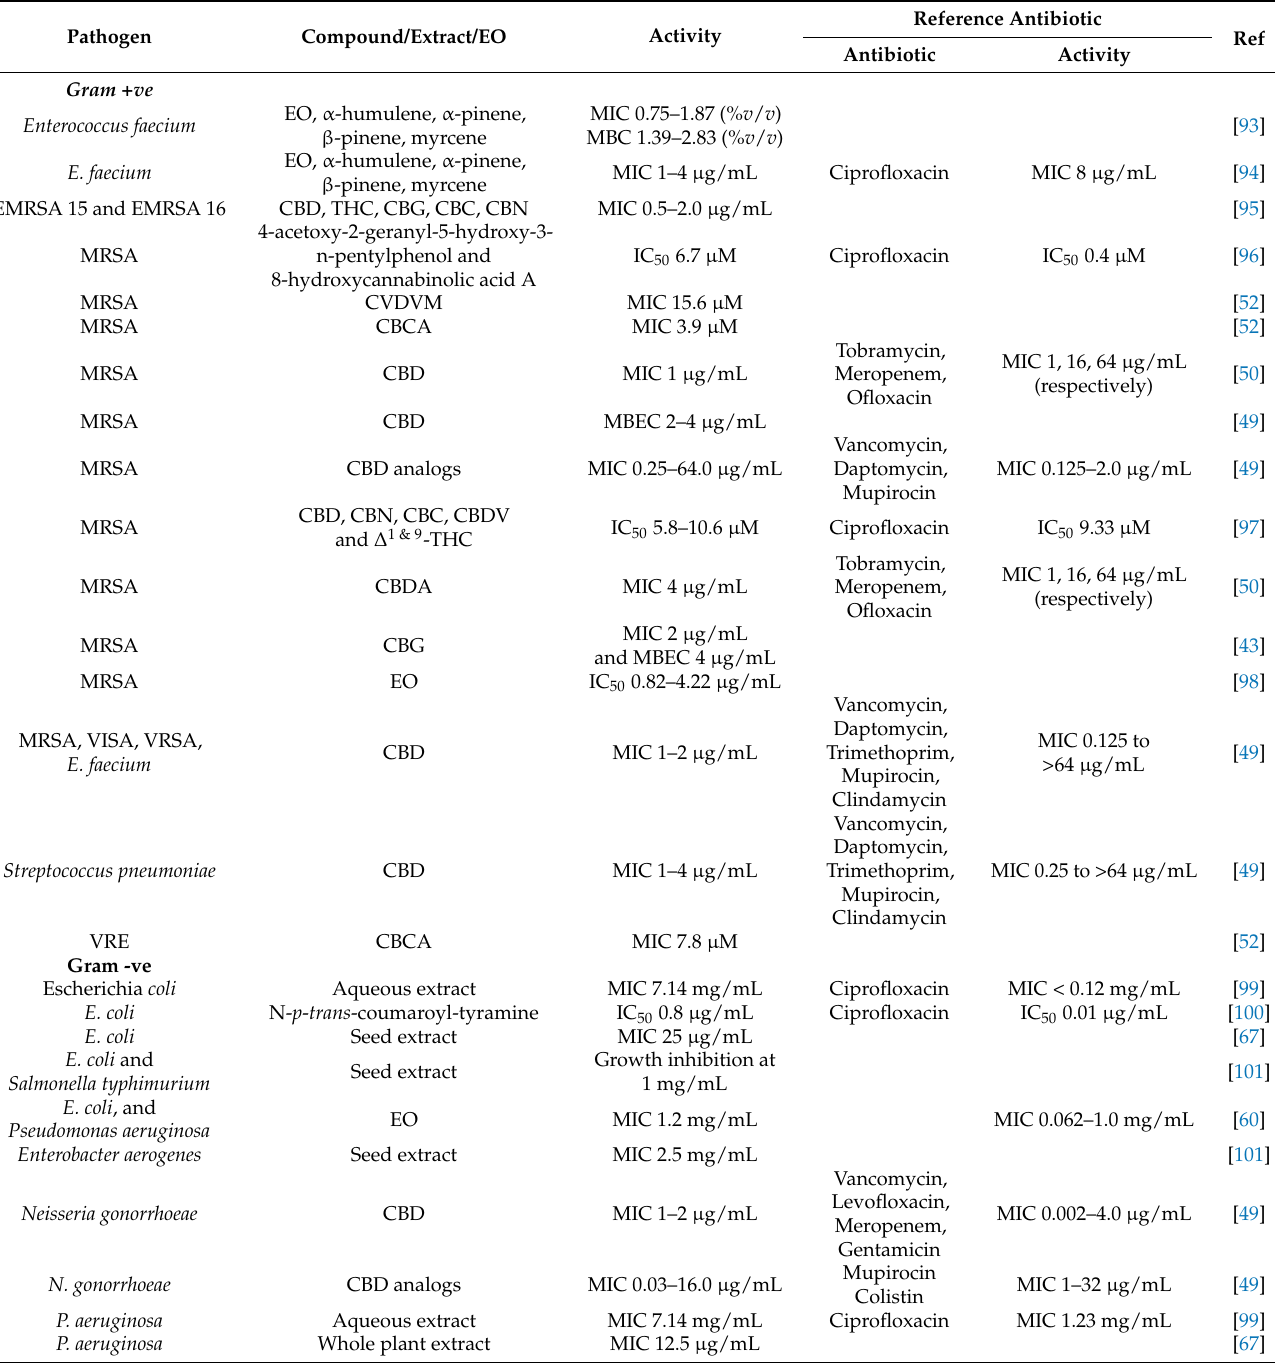
activity is comparable with penicillin and amoxicillin [10], which are commercially used as beta-lactam antibiotics for strep-throat treatment. Table 1. Activity of cannabinoids and C. sativa against the resistant pathogens enlisted in WHO’s current priority list.